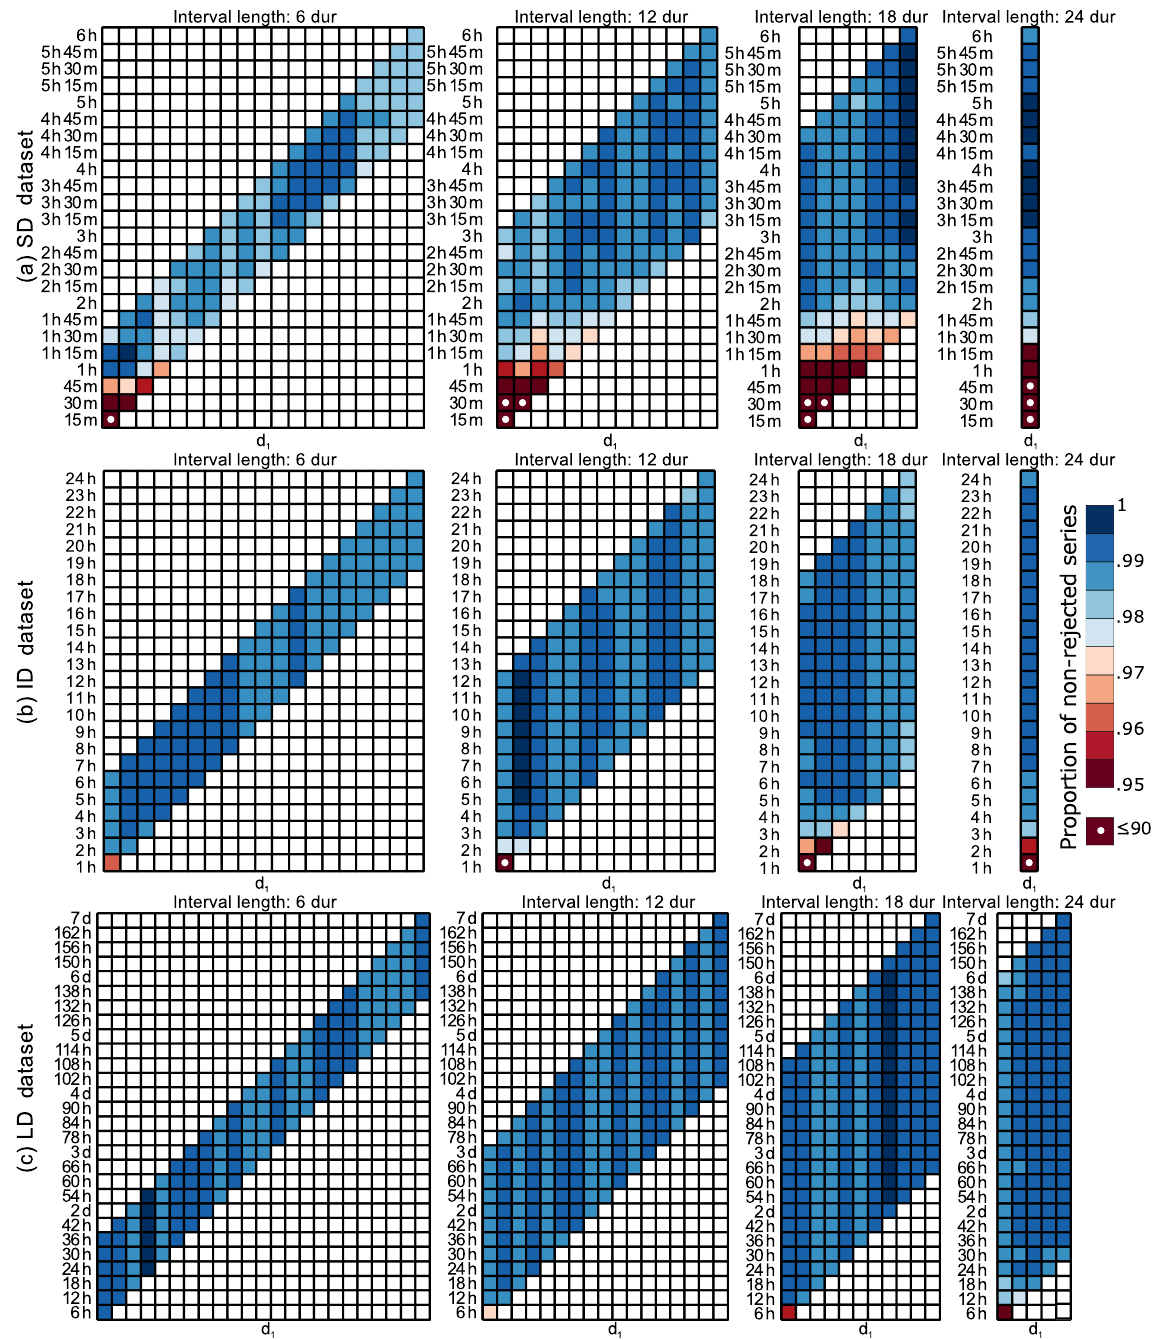
Figure 2. Proportion of stations satisfying both the slope and GOF tests applied at the 0.95 confidence level, for each duration (vertical axis) and scaling interval (horizontal axis) for the SD, ID, and LD datasets (panels a , b , and c , respectively). White circles indicate proportions between 0.25 and 0.90. See Fig. 1b and f for the identification of durations and scaling intervals within each